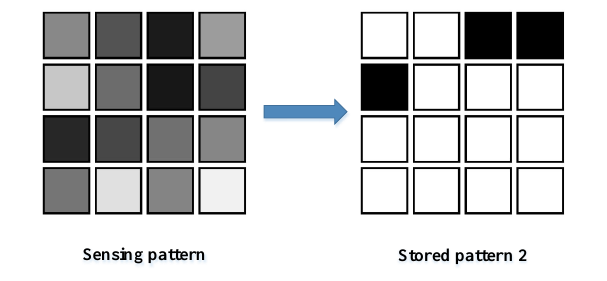
Figure 9. The detected pattern on the second layer and the similarity measure with the second stored pattern. The similarity measurement is based on network synchronization time and